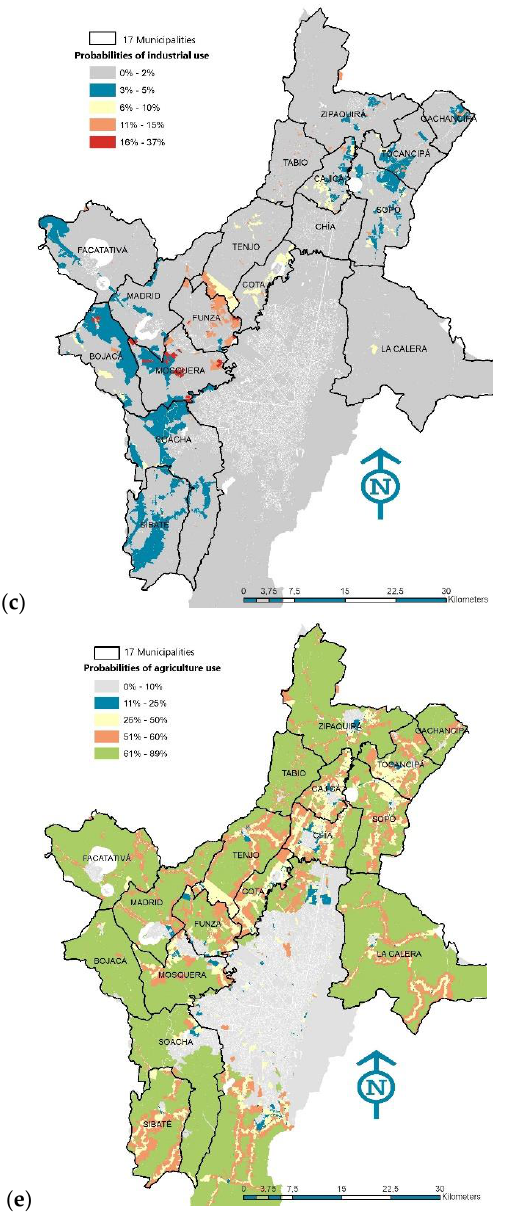
Figure 5. Probabilities estimated for each of the land use categories: ( a ) probabilities of residential use; ( b ) probabilities of commercial use; ( c ) probabilities of industrial use; ( d ) probabilities of public use; and ( e ) probabilities of agricultural use.